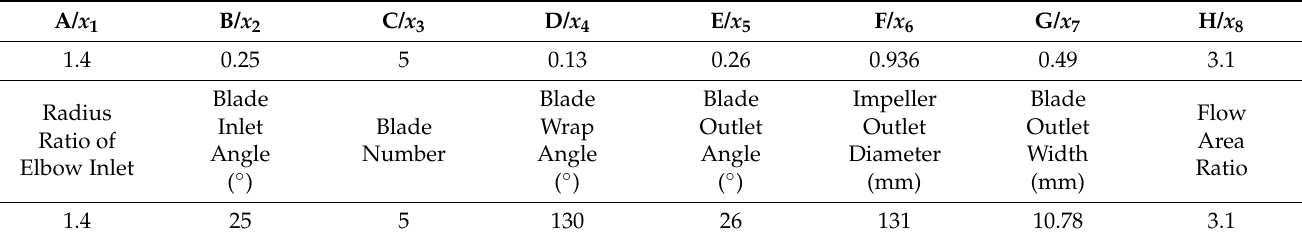
Figure 20. GA_PSO fitness curve. Table 13. Optimized parameters of centrifugal pump with